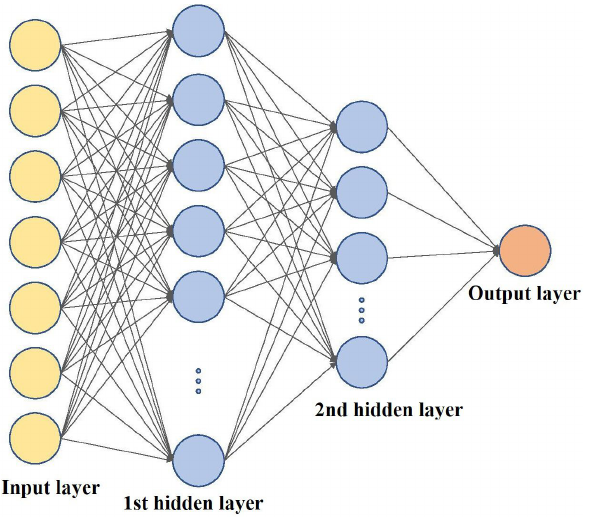
Figure 18. Example of a Neural Network Architecture. Algorithm Evaluation